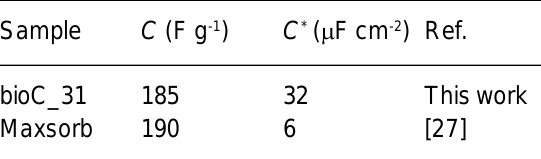
Table 3. Comparison of characteristics of the mono- lithic bioC_31 electrode and the electrode built from the commercial activated carbon Maxsorb (90 wt.% active mass + 10 wt.% PVDF) in 1 M H capacitance values are compared for CV experi- ments using a 2 mV s -1 scan rate.